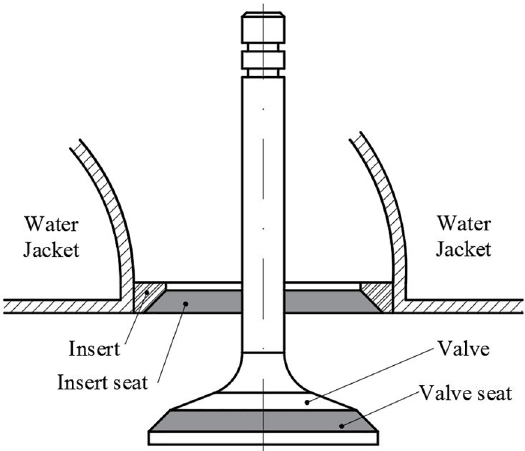
Figure 1. Schematic drawing indicating the valve and insert position in an internal combustion